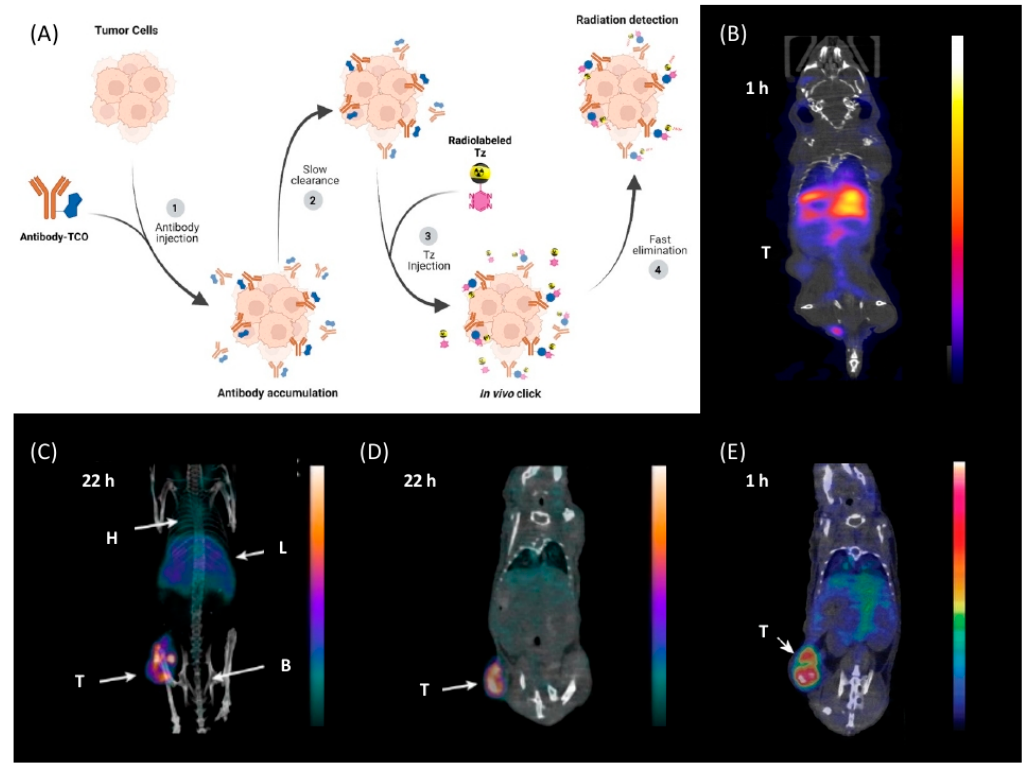
Figure 4. ( A ) Visualization of the pretargeting based on tetrazine. ( B – E ) Pretargeted imaging of CC49-TCO injected 72 h before the effector molecule in mice bearing LS174T tumor xenograft. ( B ) Conventional imaging of 111 In-label CC49 after 1 h, low uptake is observed in the tumor; ( C ) SPECT/CT images with [ 111 In] 1 22 h after Tz imaging agent injection. High tumor uptake is observed. KGaA, Weinheim [6,75]. ( D ) PET/CT image with [ 64 Cu] 4 in mice bearing the LS174T tumor xenograft. High tumor uptake is observed [75]. ( E ) PET/CT image with [ 18 F] 25 in mice bearing the LS174T tumor xenograft. High tumor uptake is already observed one hour after injection. Reprinted/adapted with permission from [76]. Copyright © 2021, American Chemical Society.